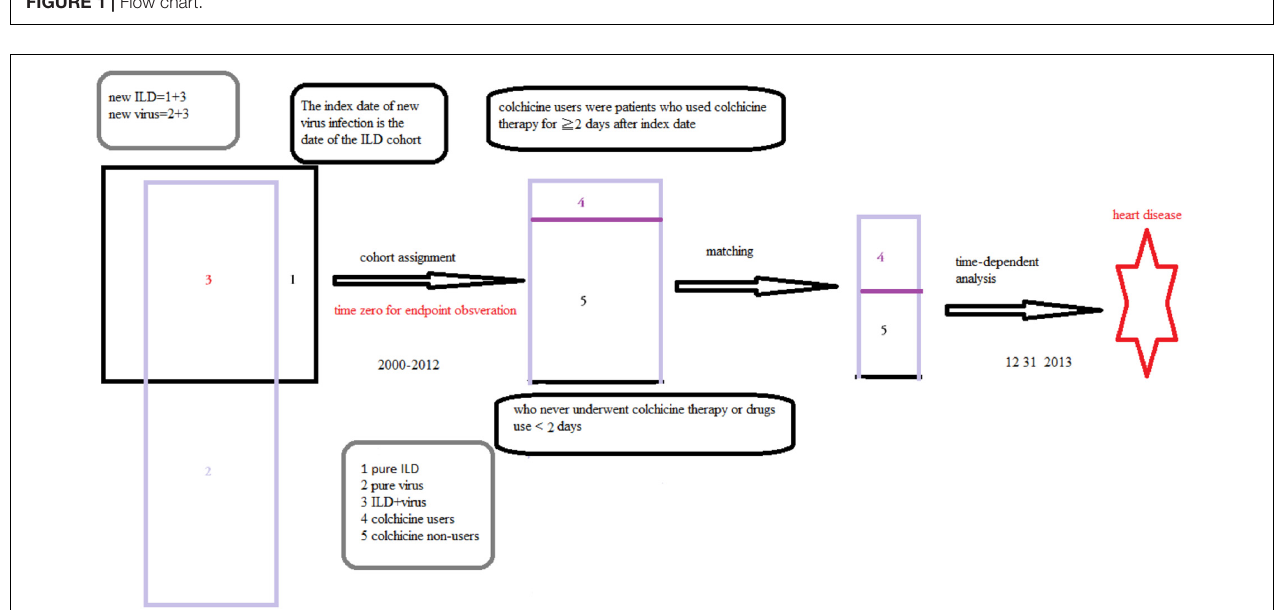
diastolic pressure, dBP, mean blood pressure, and mBP).